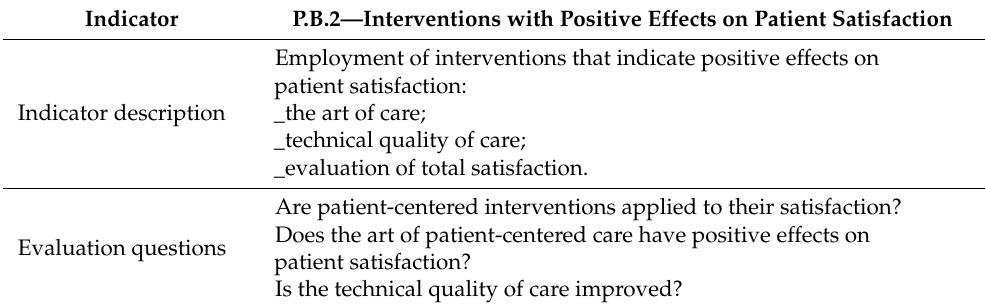
Table 7. The indicator P.B.2—Interventions with positive effects on patient satisfaction.